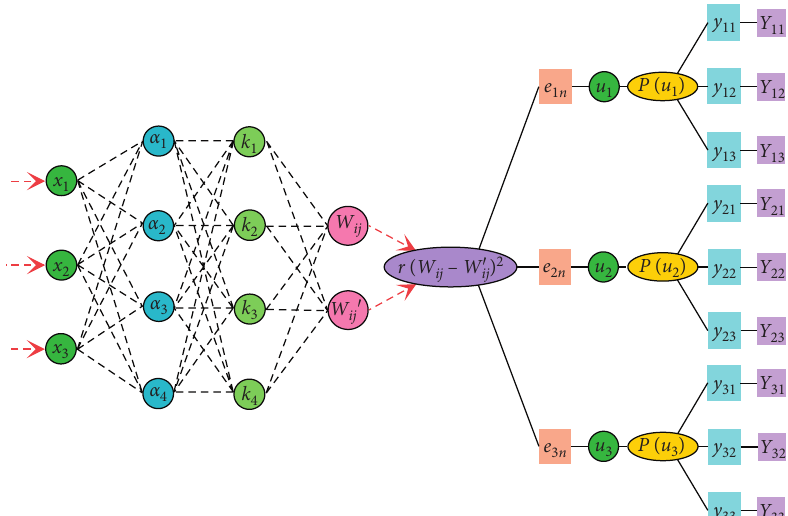
Figure 3: Analysis process of the human resource management risk inducement system based on the BP neural